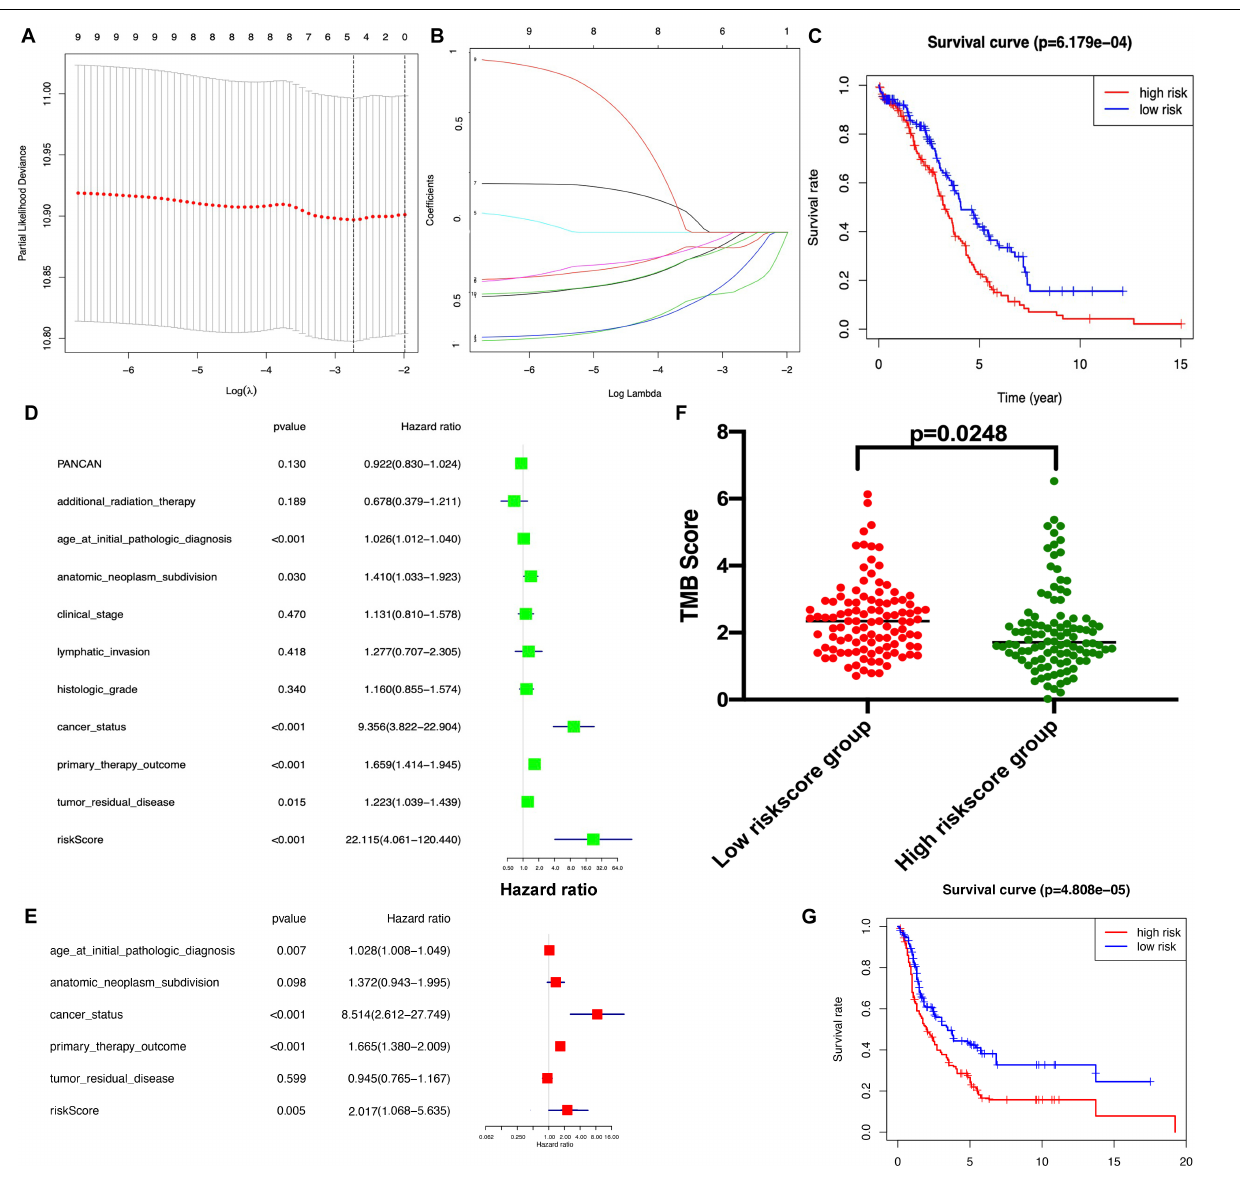
FIGURE 8 | Lasso regression identified the prognostic model of five-immune related gene signature. (A,B) . Lasso regression complexity was controlled by lambda using the glmnet R package. (C) Overall survival analysis between high-risk score and low-risk score groups based on TCGA dataset. (D) The univariate analysis of risk factors in OC. (E) The multivariate analysis of risk factors in OC. (F) The association between TMB and risk score group. (G) Overall survival analysis between high-risk score and low-risk score groups based on GEO dataset. Statistical significance was set as p <